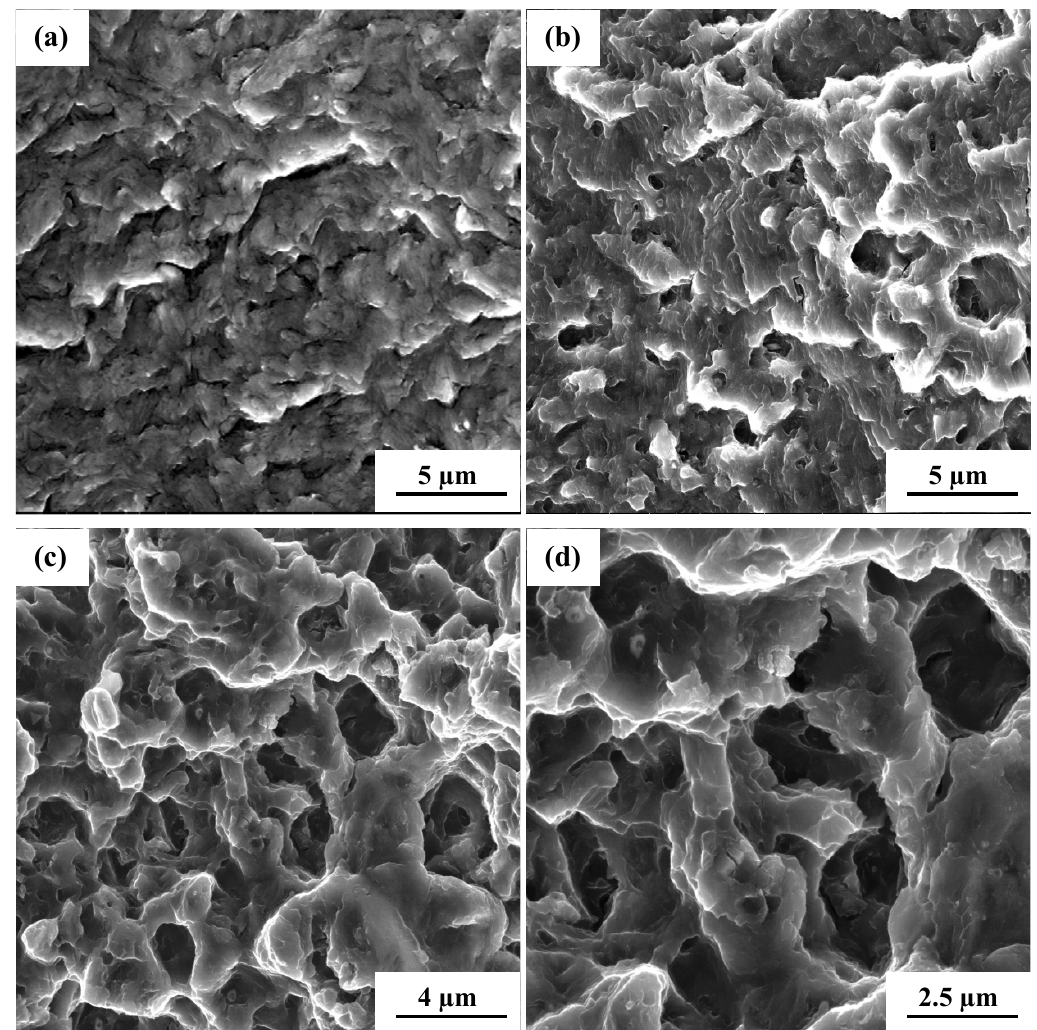
Figure 14. Scanning electron micrographs of the high cycle fatigue fracture surface of AZ31 cyclically deformed at maximum stress of 149.67 MPa and load ratio of − 1.0 and fatigue life of 13,802 cycles, showing: ( a ) High magnification observation of ( b ) showing an array of macroscopic cracks and fine microscopic cracks; ( b ) Fine and shallow striation-like features in the region of stable crack growth; ( c ) The overload fracture surface showing voids and shallow dimples reminiscent of locally ductile failure and ( d ) High magnification of (b) showing the irregular size and shape of the voids.